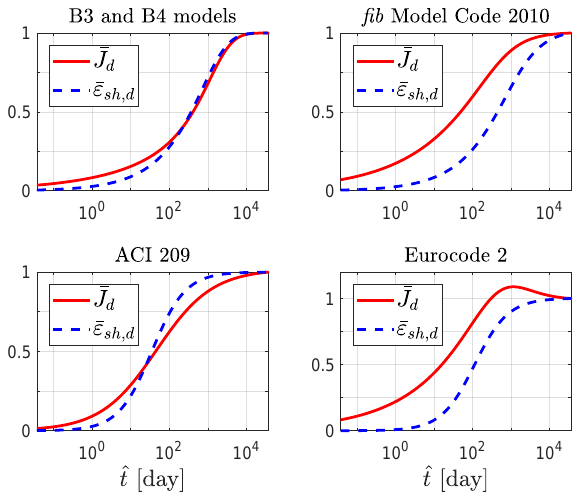
Figure 2. Time evolution of normalized drying creep and shrinkage according to the selected design codes and prediction models. The functions are normalized with respect to the ultimate value. Decreasing drying creep from EC2 model is physically unjustified and stems from the model